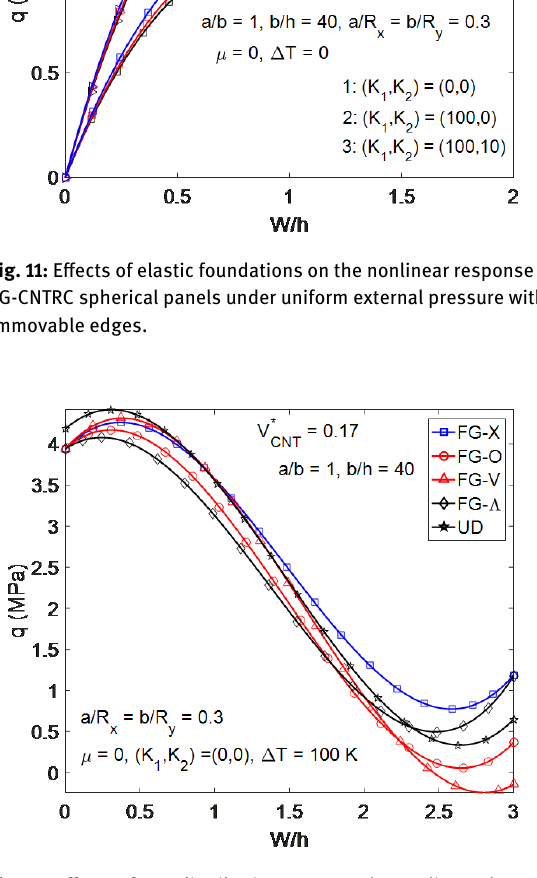
Fig. 12: Effects of CNT distribution types on the nonlinear thermo- mechanical response of FG-CNTRC spherical panels with immovable